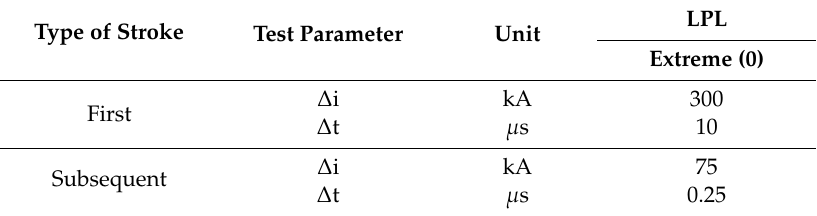
Table 1. Test parameters for simulations showing the extreme case for LPL [23].